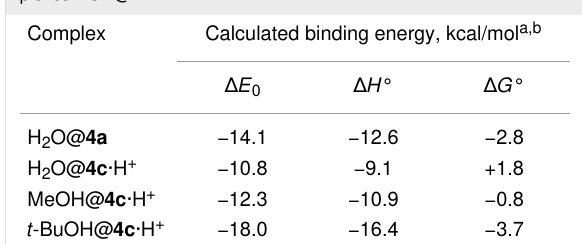
Table 1: DFT calculated binding energies for the guest–host com- plexes ROH@ 4